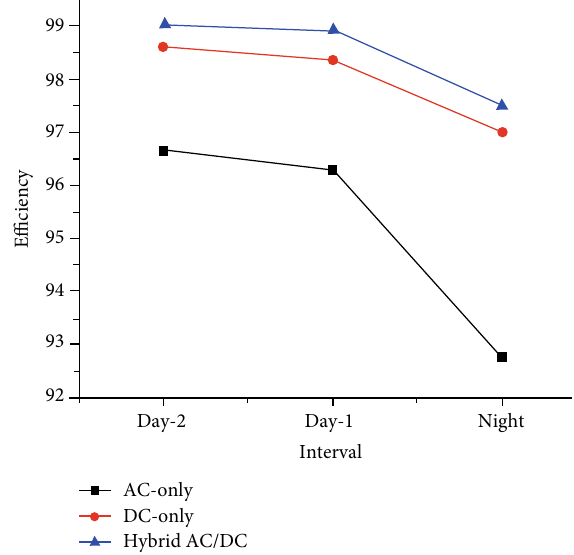
Figure 27: Conversion losses for 1st day, 2nd day, and night